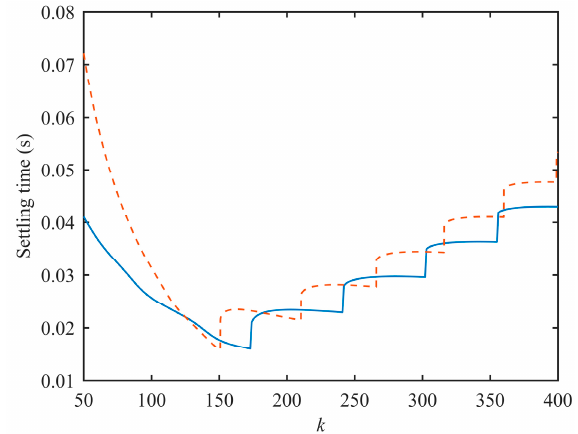
Figure 13. 2% settling time as a function of k .